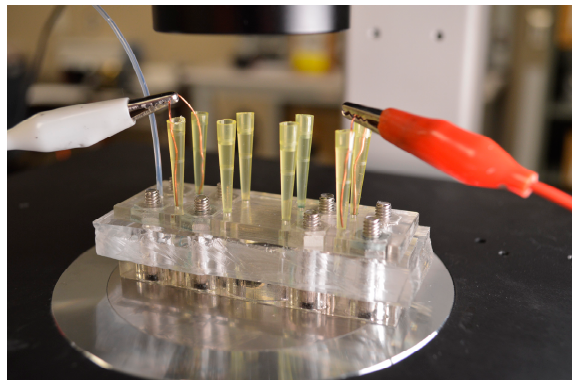
Figure 3. Image of the layered microfluidic device in operation set a-top an inverted microscope for analysis.